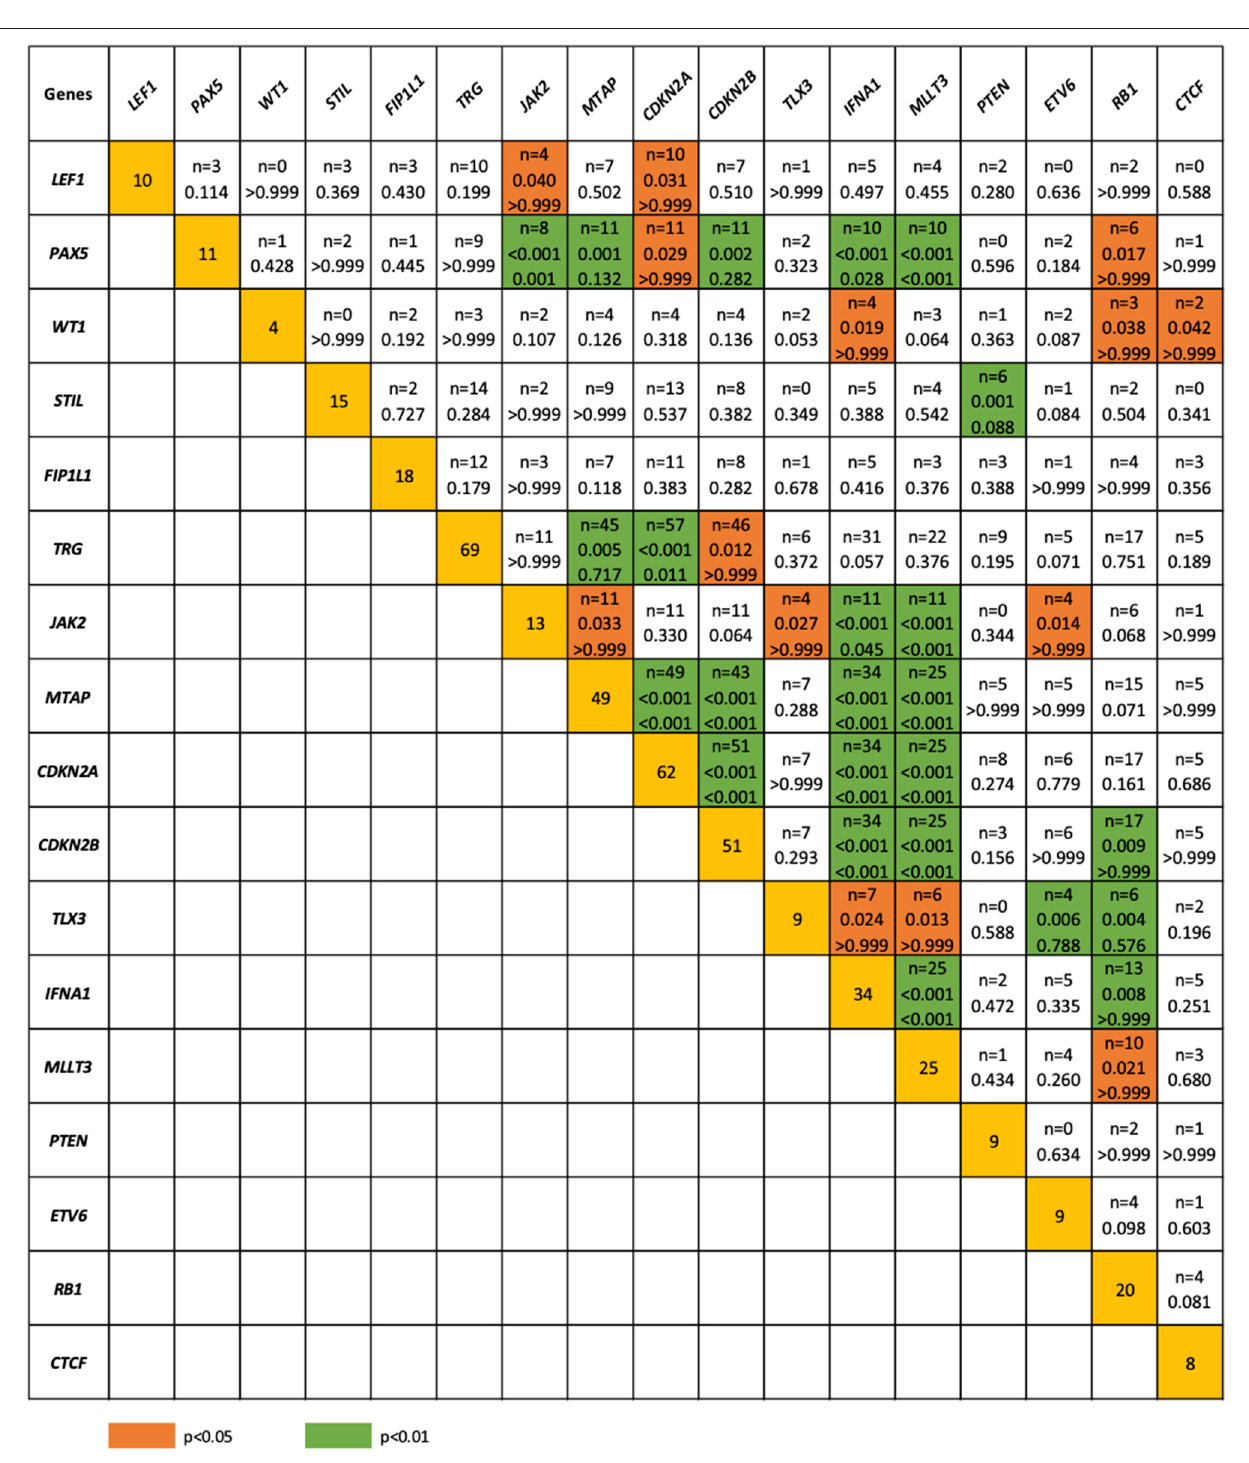
Frontiers in Oncology | www.frontiersin.org